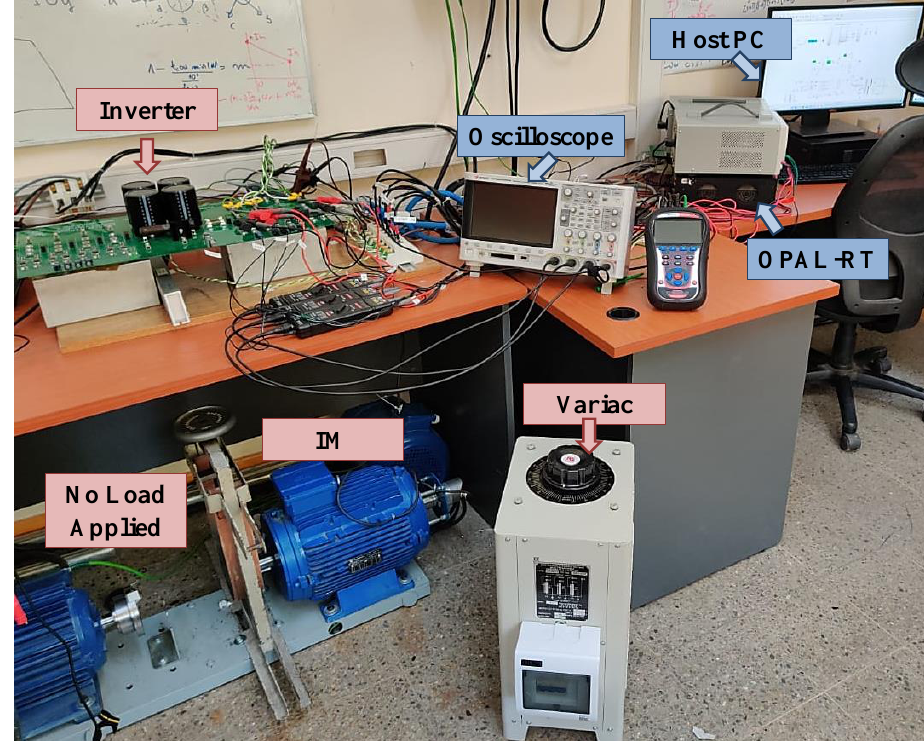
Figure 13. Picture of the test